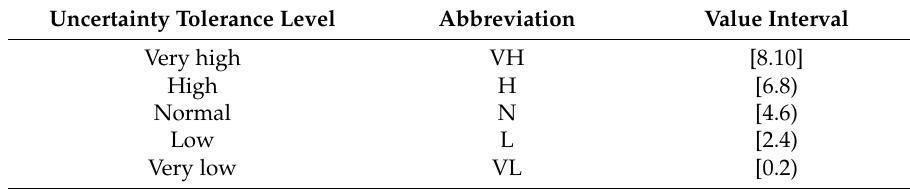
Table 1. Linguistic terms and value interval for rating the uncertainty tolerance.